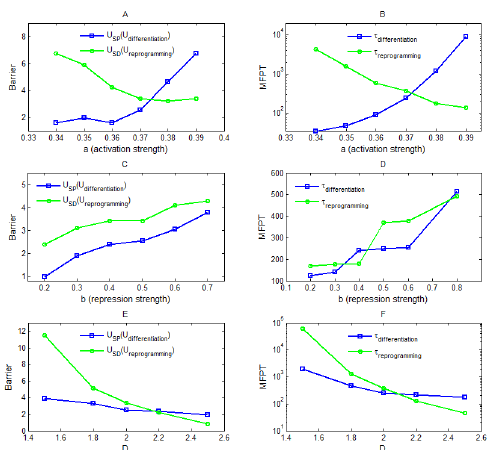
Figure 4. The barrier height and MFPT (mean first passage time) results when the activation strength a , the repression strength b as well as the noise level D changes (Langevin dynamics). (A)(B) show that when a increases, stem cell state becomes more stable, the barrier for stem cell state U SP (or the barrier for differentiation process U differentiation ) increases, and the MFPT for differentiation process from stem cell state to differentiation state ( t differentiation ) increases. By contrast, When a increases, differentiation state becomes less stable, the barrier for differentiation state U SD (or the barrier for reprogramming process U reprogramming ) decreases, and the MFPT for reprogramming process from differentiation state to stem cell state ( t reprogramming ) declines. (C)(D) show that when b increases, the barrier for stem cell state U SP ( U differentiation ), the barrier for differen- tiation state U SD ( U reprogramming ), the MFPT for differentiation process ( t differentiation ), and the MFPT for reprogramming process ( t reprogramming ) all increase. (E)(F) show that when noise level D increases, the barrier for stem cell state U SP ( U differentiation ), the barrier for differentiation state U SD ( U reprogramming ), the MFPT for differentiation process ( t differentiation ), and the MFPT for reprogramming process ( t reprogramming ) all